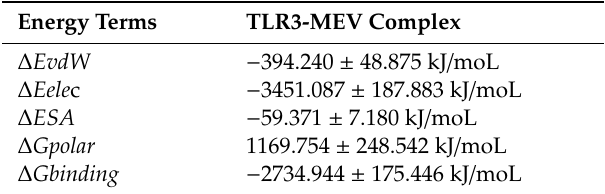
Table 5. Binding energy (kcal / moL) analysis of the TLR3-MEV complex. ∆ EvdW : van der Waals interaction energy; ∆ Eelec : electrostatic interaction energy ; ∆ ESA : SAS energy; ∆ Gpola : polar solvation energy; ∆ Gbinding : binding